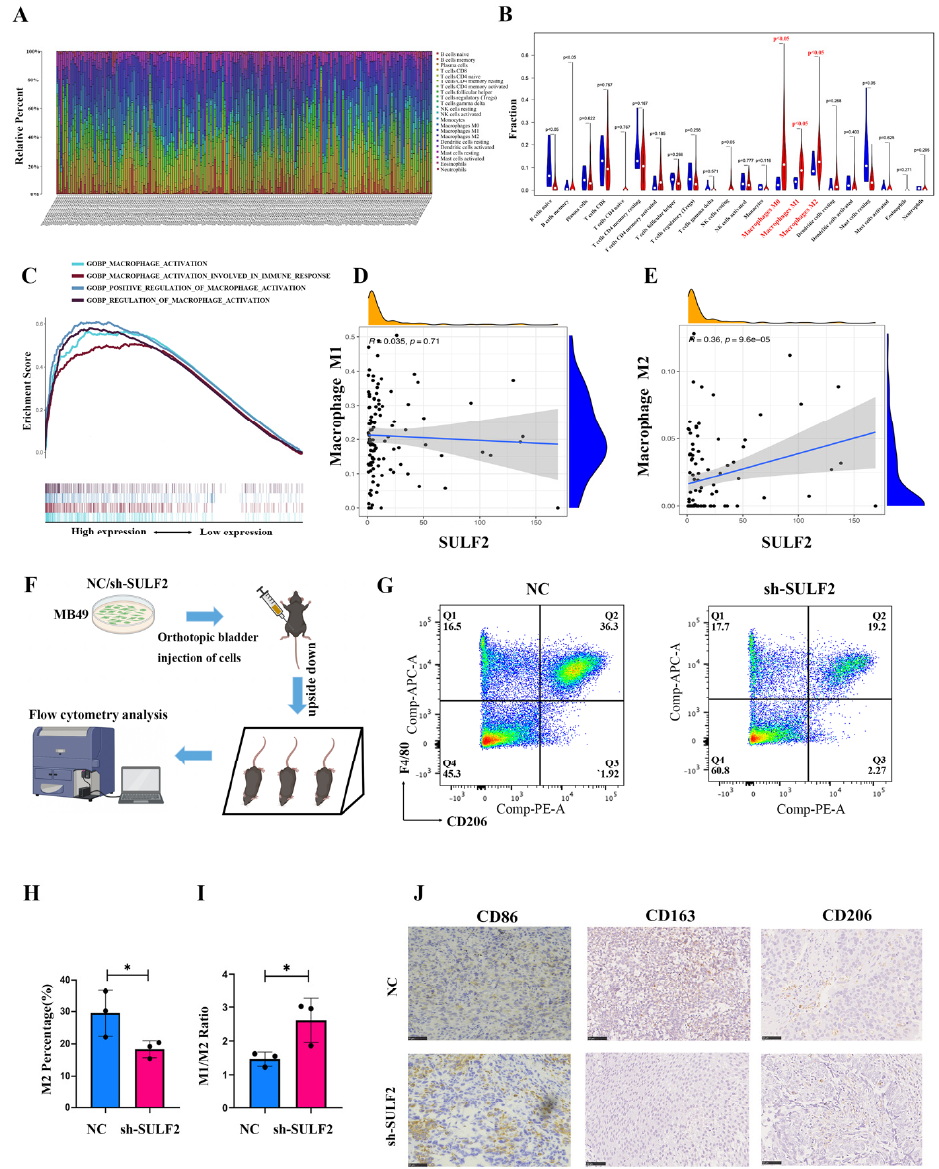
Figure 5. SULF2 is closely related to macrophages in the BCa microenvironment. ( A , B ) TCGA database analyzes the proportion of different types of immune cells in the microenvironment of BCa.